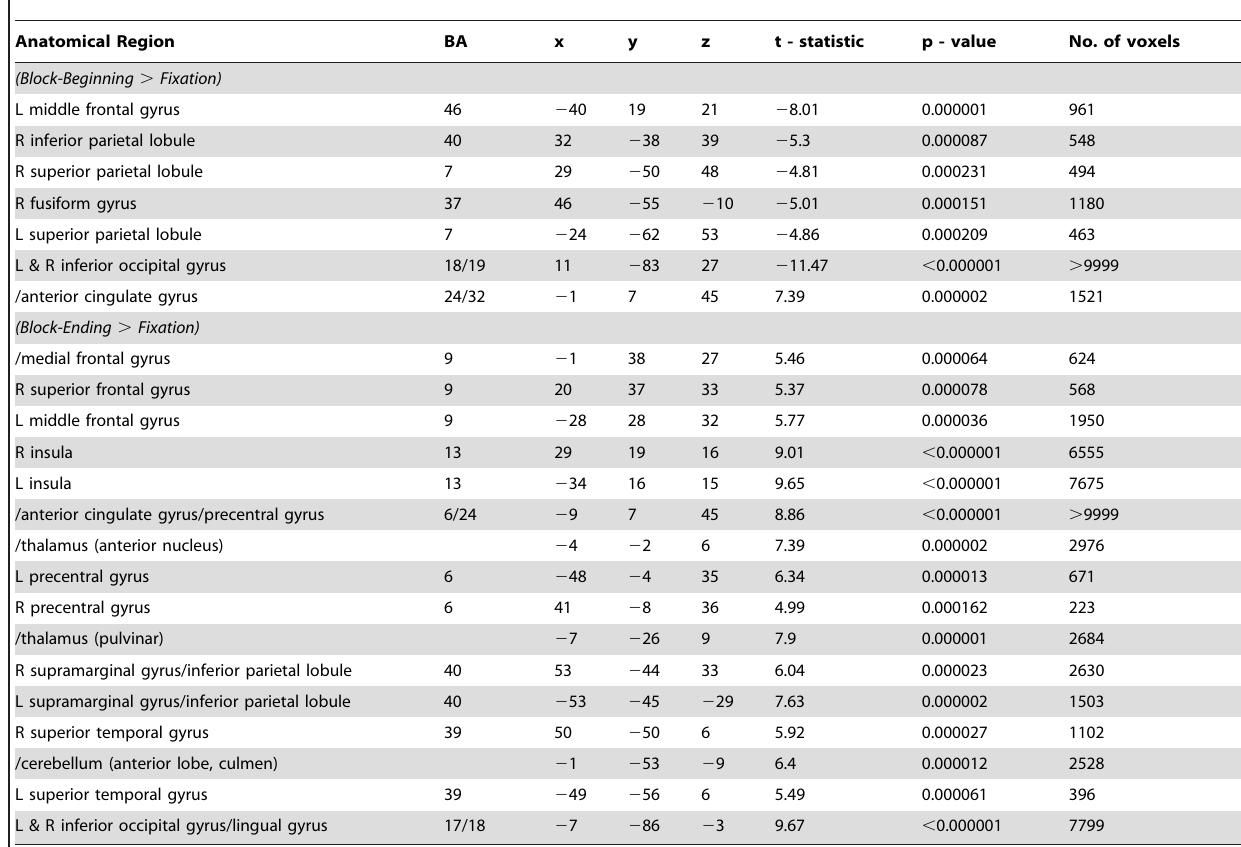
Table 3. fMRI results for the Block-Beginning . Fixation/Block-Ending . Fixation contrasts.